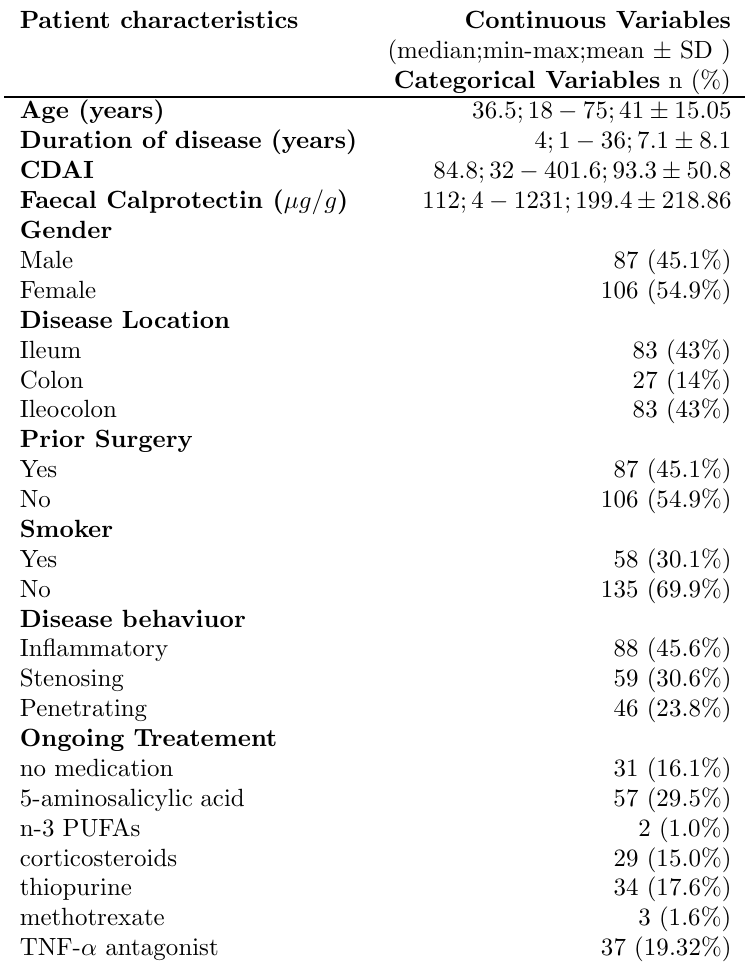
Clinical characteristics of CD patients. (PUFAs, polyunsaturated fatty acids; CDAI, Crohn’s disease activity index; TNF- α , tumor necrosis factor- α